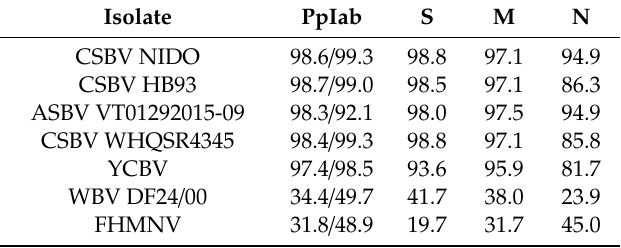
Table 2. Putative protein amino acid sequence identity (%) between chinook salmon bafinivirus (CSBV) isolate Cefas-W054 and other piscaniviruses: CSBV NIDO, isolated from Chinook salmon bafinivirus; ASBV: ASBV VT01292015-09, isolated from Atlantic salmon; YCBV: yellow catfish bacilliform virus; CSBV HB93, isolated from crucian carp; CSBV WHQSR4345, isolated from lesser spiny eel; WBV DF24 / 00, isolated from white bream virus; and FHMNV, isolated from fathead minnow nidovirus. Replicase polyprotein (ppIab), spike (S), membrane protein (M) and nucleocapsid protein (N). Isolate